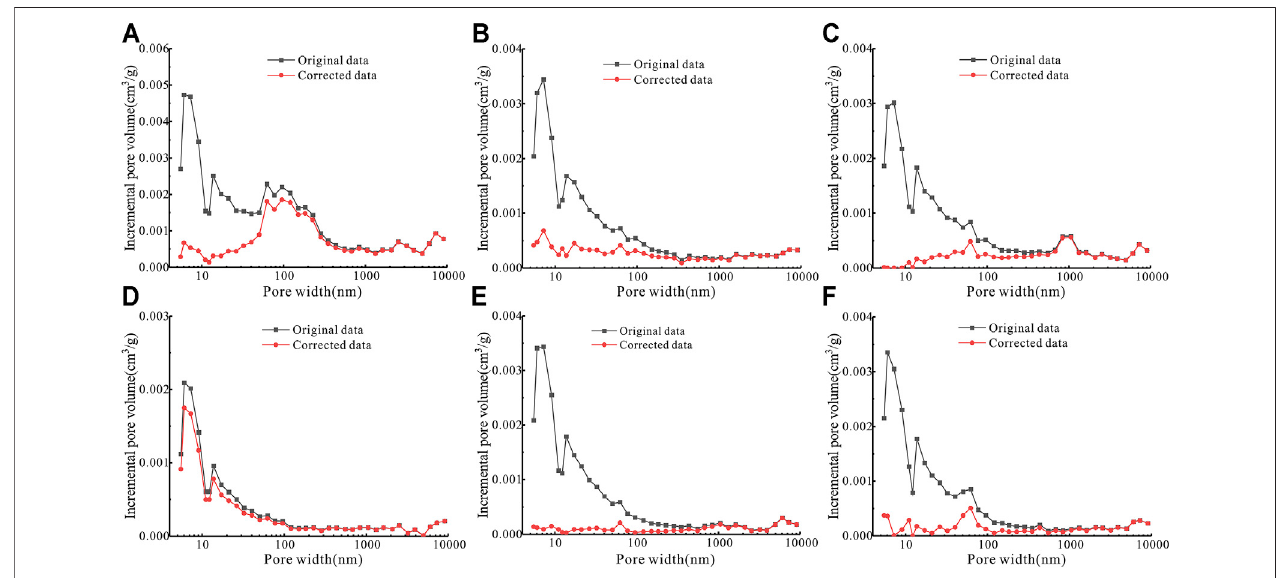
FIGURE 3 | The curve of incremental mercury intrusion and pore